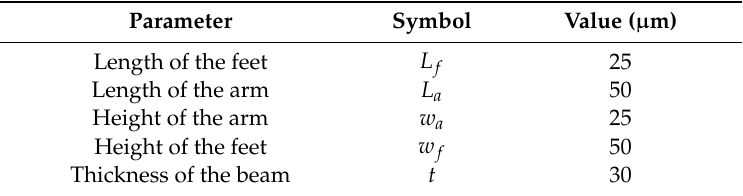
Table 1. Description of the micro